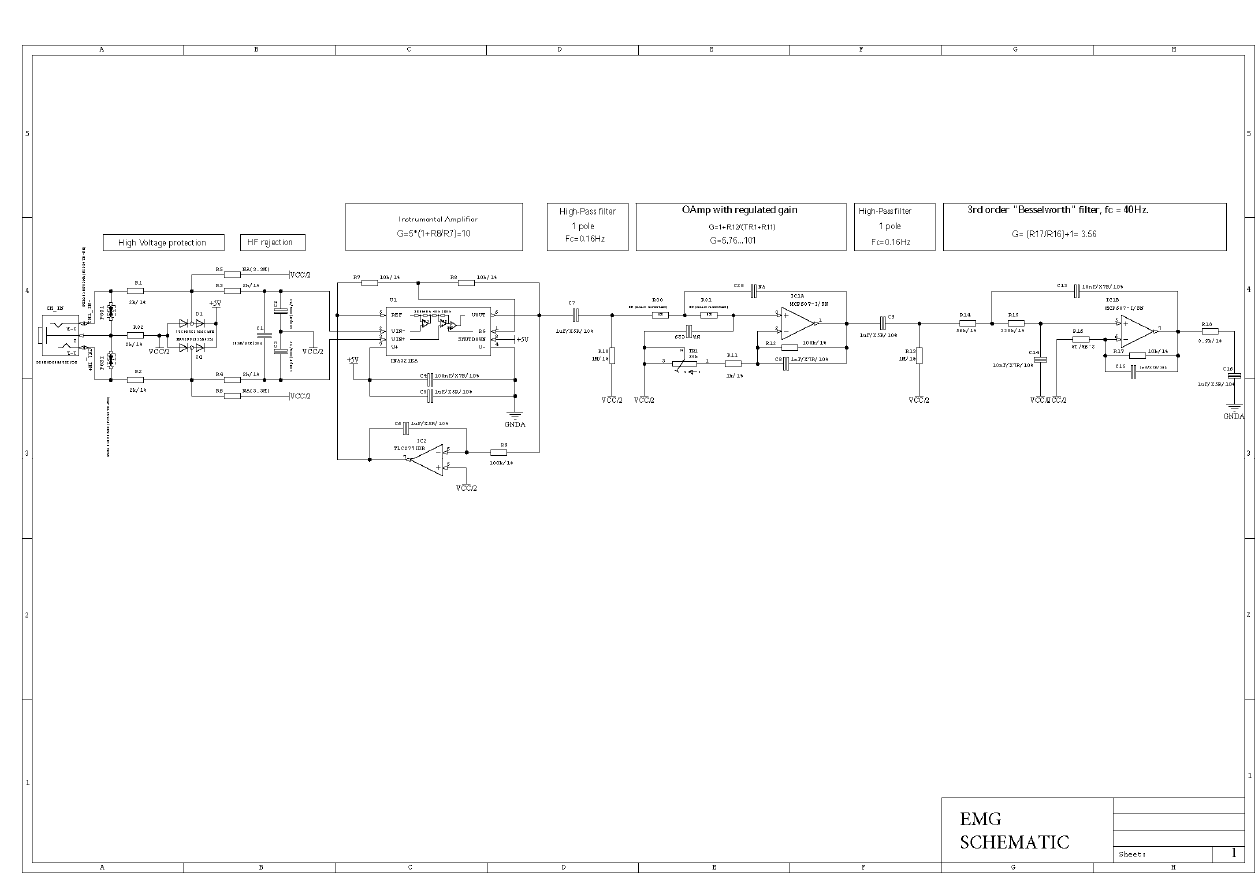
Figure A1. EMG Figure A1. EMG schematic.